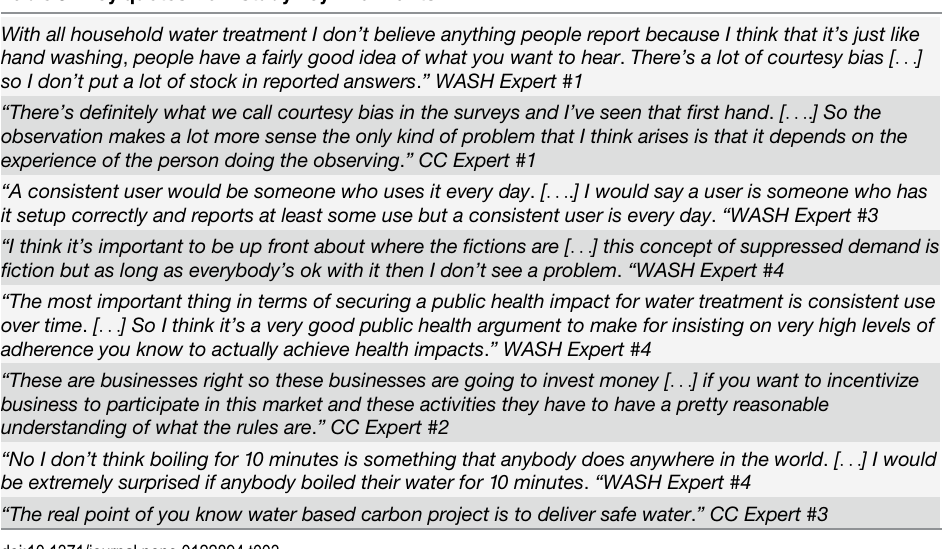
Table 3. Key quotes from study key